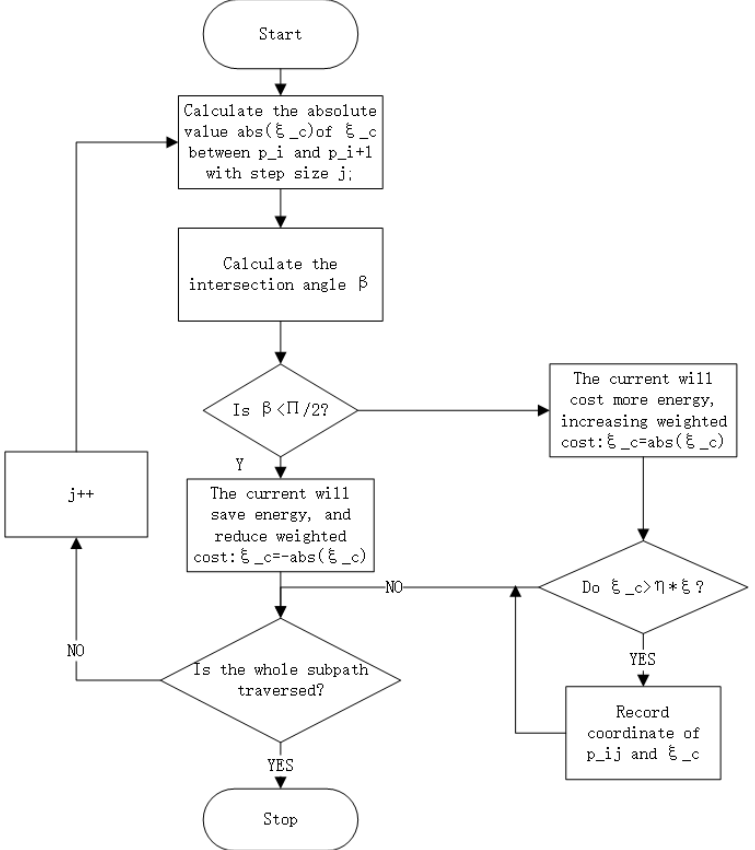
Figure 9. The input of the algorithm is a subpath of the overall path, and the output is the recorded area having strong currents. In the next Section 3.2.2, we discuss the replanning method to avoid the strong currents and